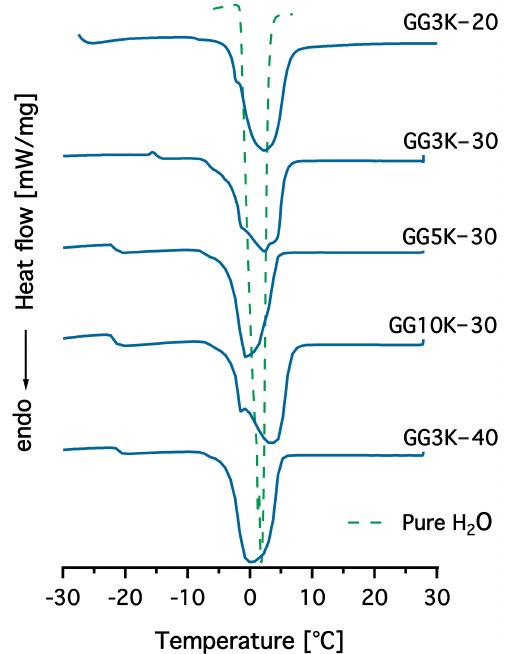
Figure 8. DSC thermograms of the fully swollen hydrogels from which the freezable water content was determined; water as reference.